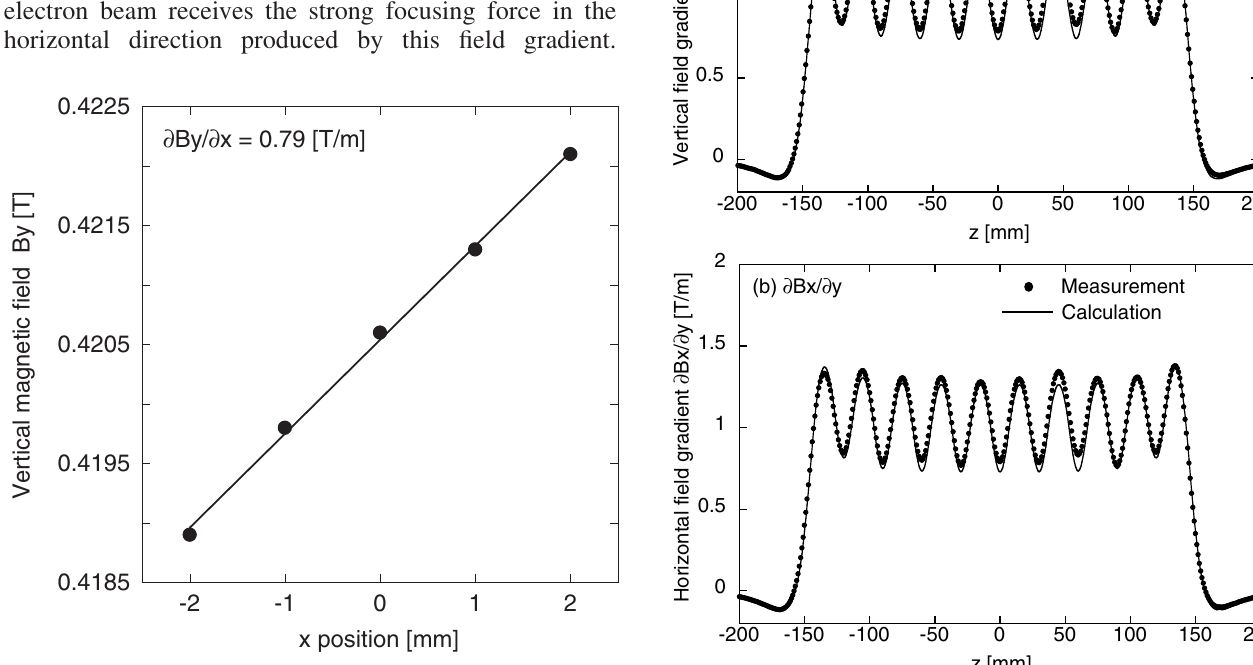
FIG. 7. Measured magnetic field B tion of the horizontal position x at the middle of the wiggler z ¼ 0 (on vertically magnetized blocks). The solid circles are mea- sured magnetic fields and the line is a fit of a straight line to them for deriving the field gradient.